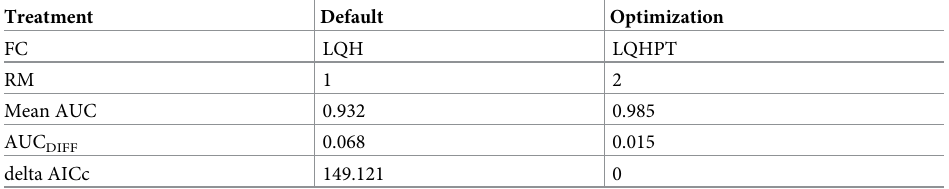
Table 2. Model performance under default and optimized settings.